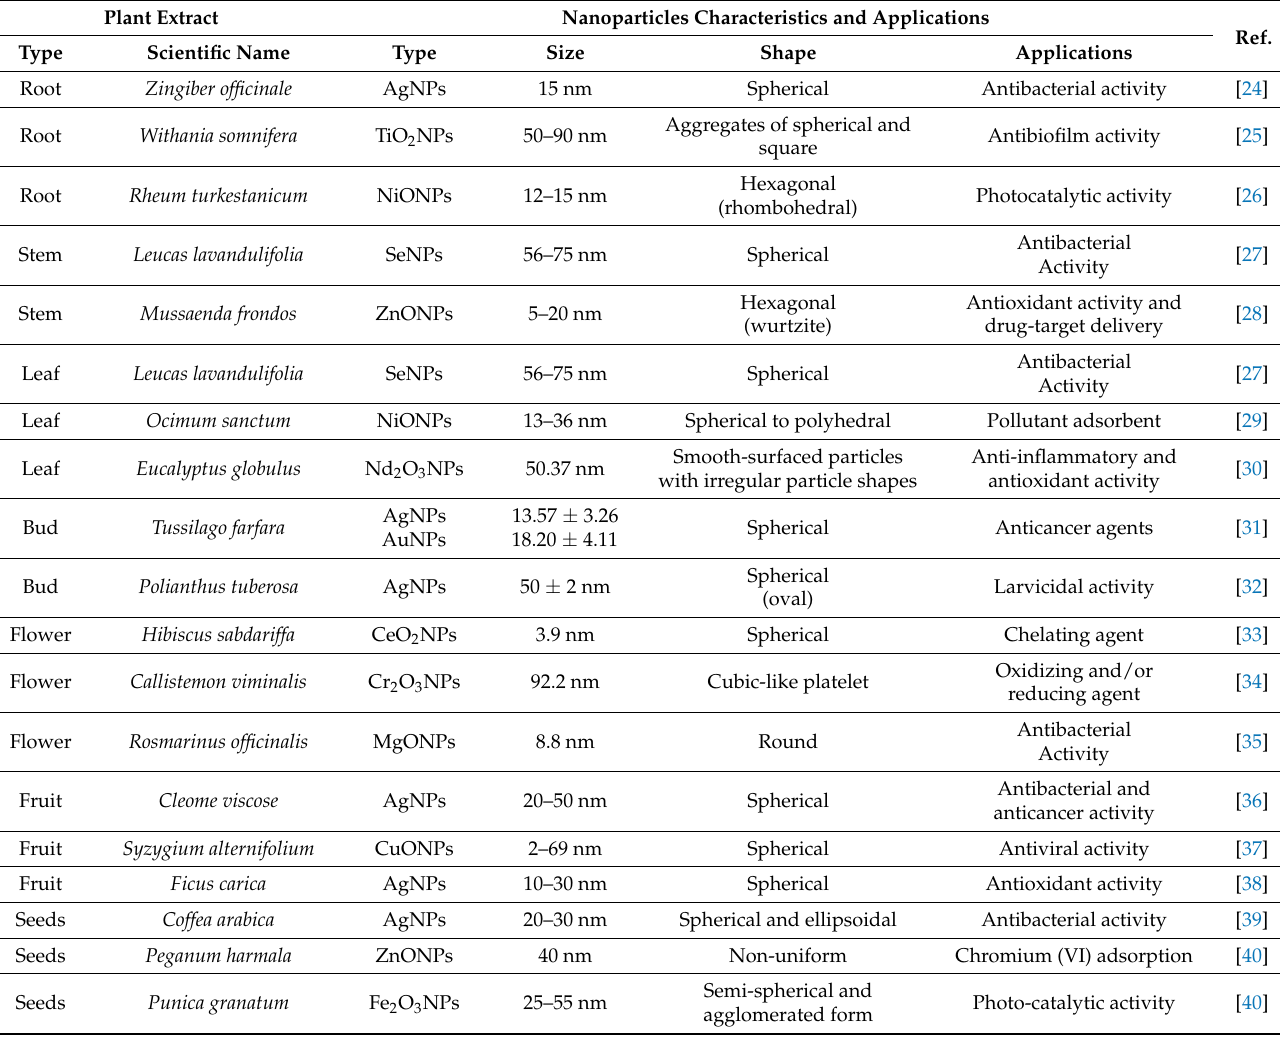
Table 1. Green synthesis of various nanoparticles using different plant parts and their